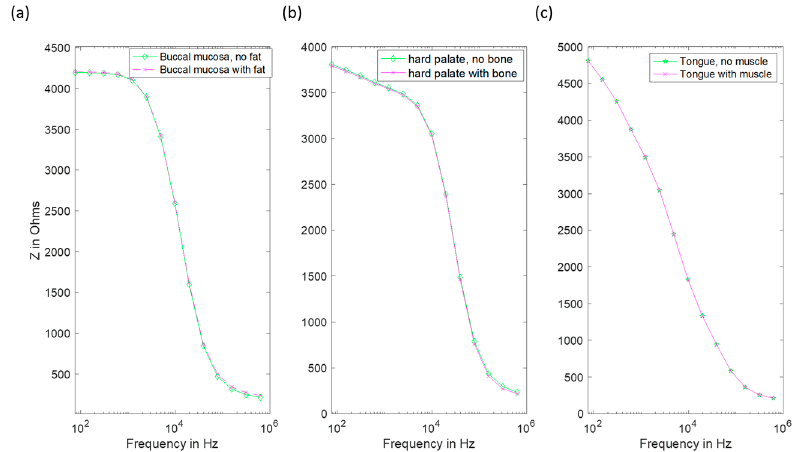
Figure 11. Impedance spectra of several oral sites with and without explicit inclusion of the appro- priate underlying layer. ( a ) The buccal mucosa with added fat. ( b ) Hard palate with added bone. ( c ) Tongue with added muscle layer (note the coincident data points in this case). 4. Discussion